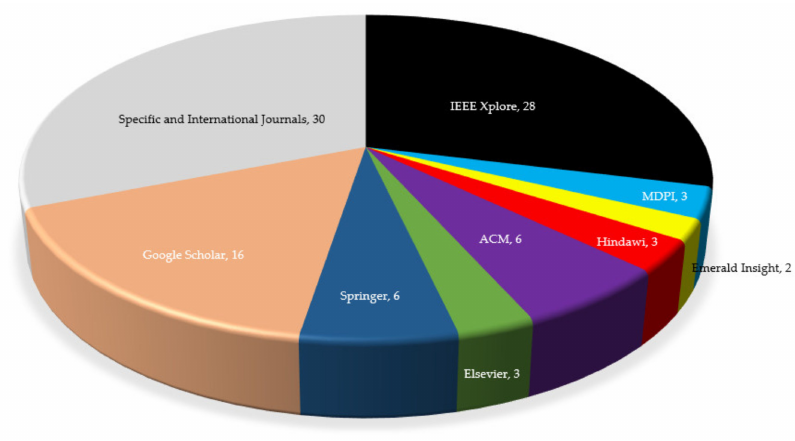
Figure 7. Summary of the number of research papers